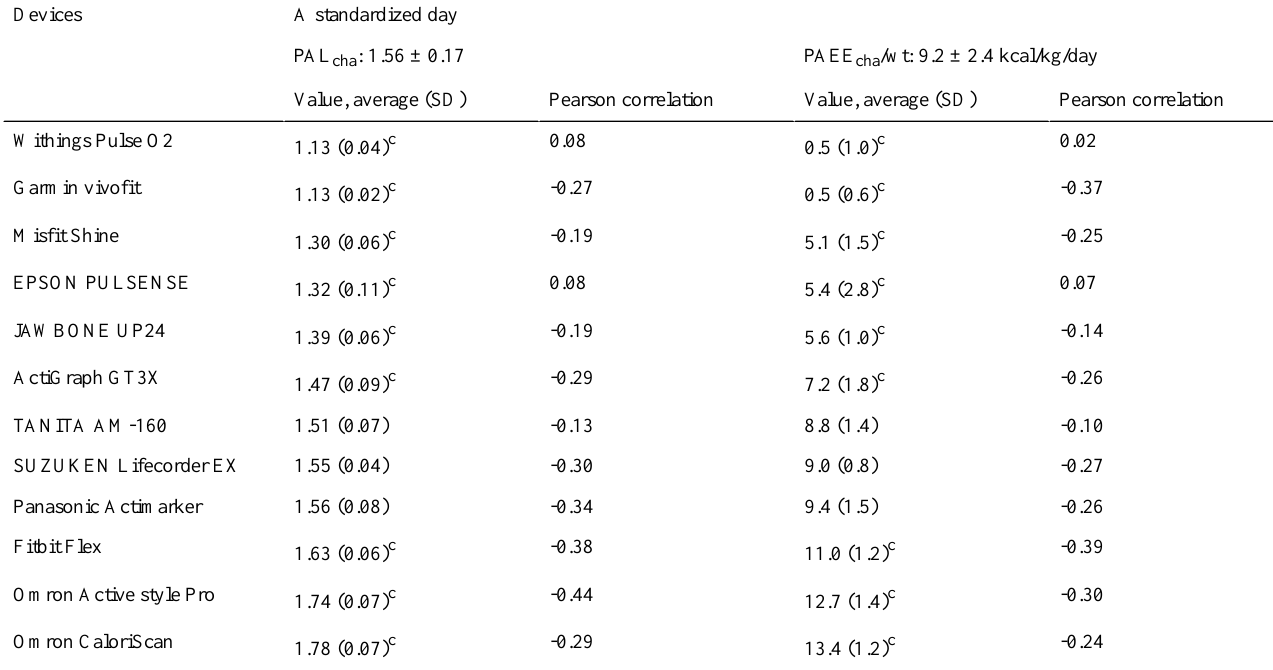
Table 3. The comparison between PAL a cha and PAL dev , PAEE b cha /wt (physical activity energy expenditure) and PAEE dev /wt.